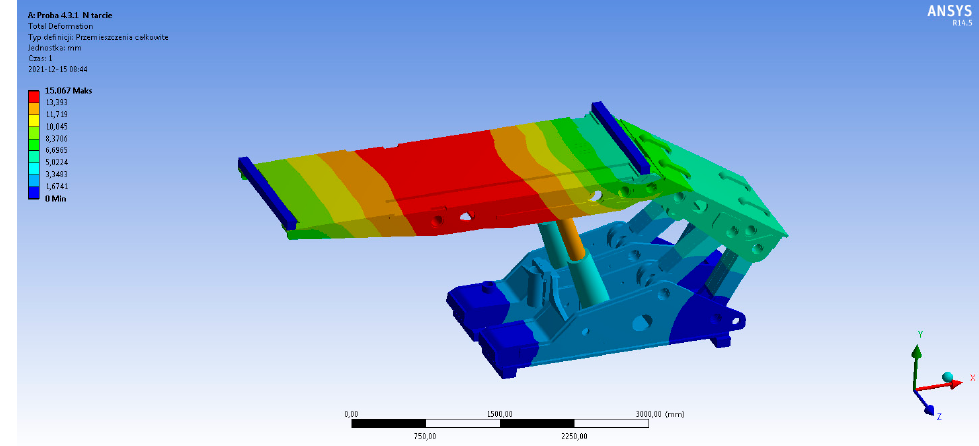
Figure 5. Load force simulation of the support’s canopy.